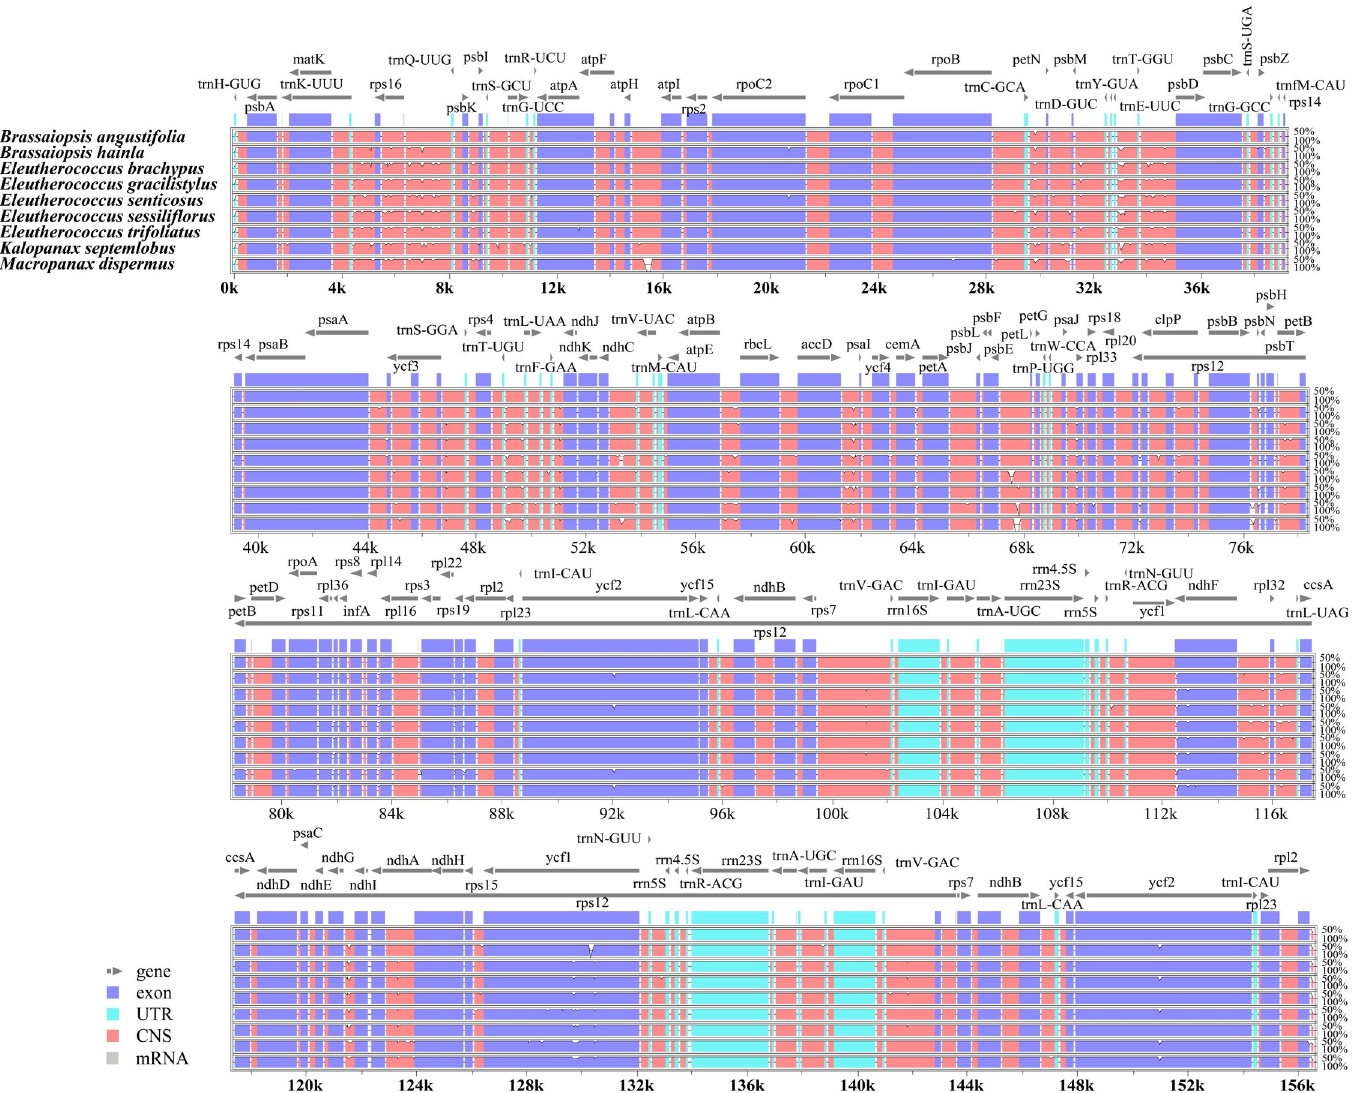
Fig 4. Complete chloroplast genome alignments for nine species of the Asian Palmate group using the mVISTA program, with the Brassaiopsis angustifolia chloroplast genome as a reference sequence. The y-scale indicates identity from 50% to 100%. Gray arrows indicate the position and direction of each gene. Red indicates conserved non-coding sequences (CNSs). Blue indicates the exons of protein-coding genes